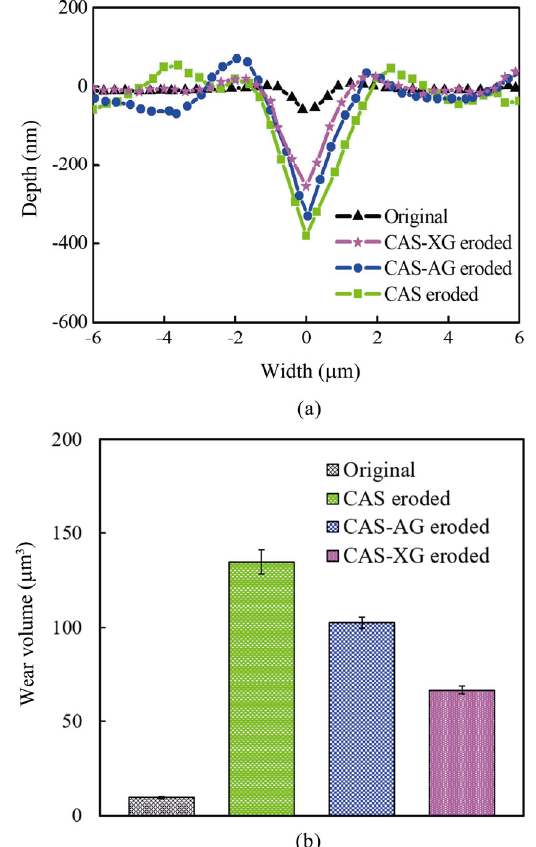
Fig. 6 Profiles and wear volumes of nano-scratches on the enamel surfaces subjected to different erosion treatments at applied load of 10 mN: (a) scratch profile; (b) wear